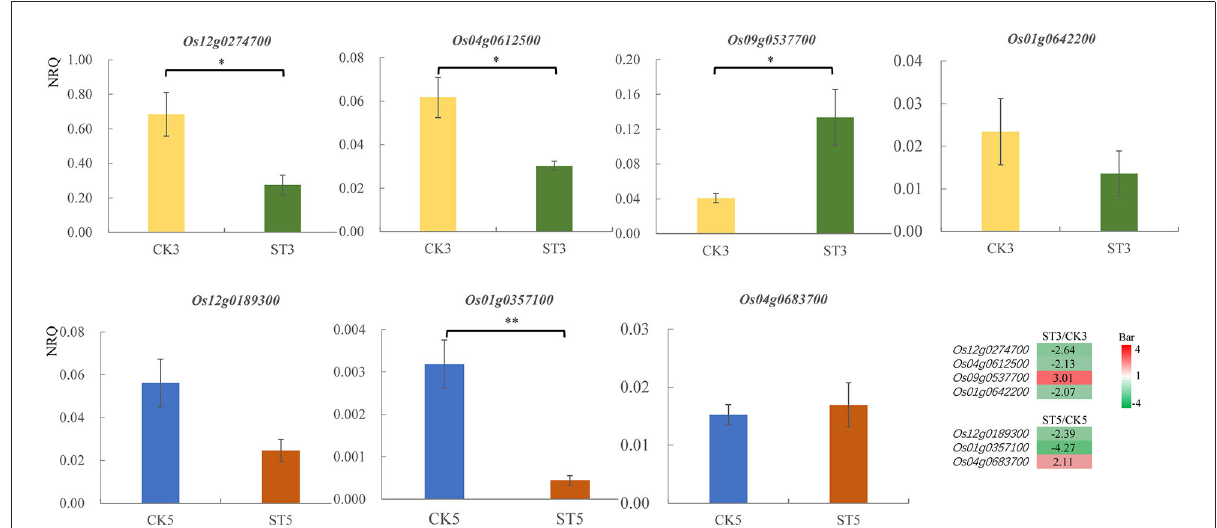
FIGURE6 Relative gene expression [normalized relative quantity (NRQ)] of differentially expressed genes from RNA-seq data analyzed by reverse-transcription quantitative PCR. Means and standard errors are shown. * P < 0.05; ** P < 0.01. CK3, after 3 d in the control; CK5, after 5 d in the control; ST3, after 3 d of salt treatment; ST5, after 5 d of salt treatment. The heatmap in the lower right corner shows the relative expression levels of differentially expressed genes by transcriptome